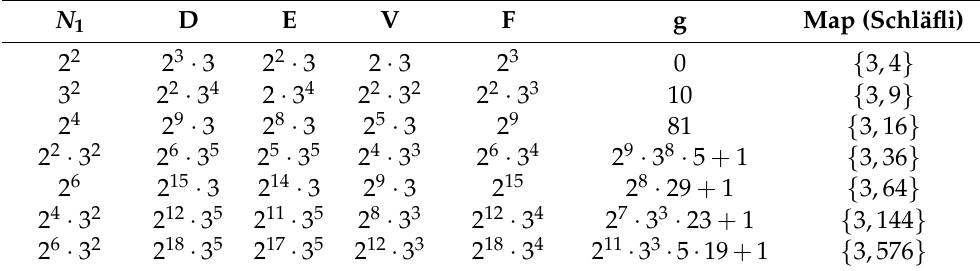
Table 1. The complete table of regular maps for N 1